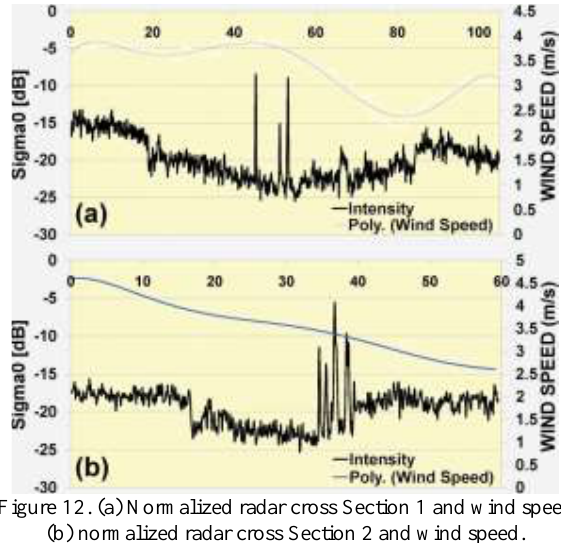
Figure 9. Map of Oil Leak Sources at Oil Rocks, Chilov and Pirallahi Islands based on the Oil Spill Frequency 2006-2010